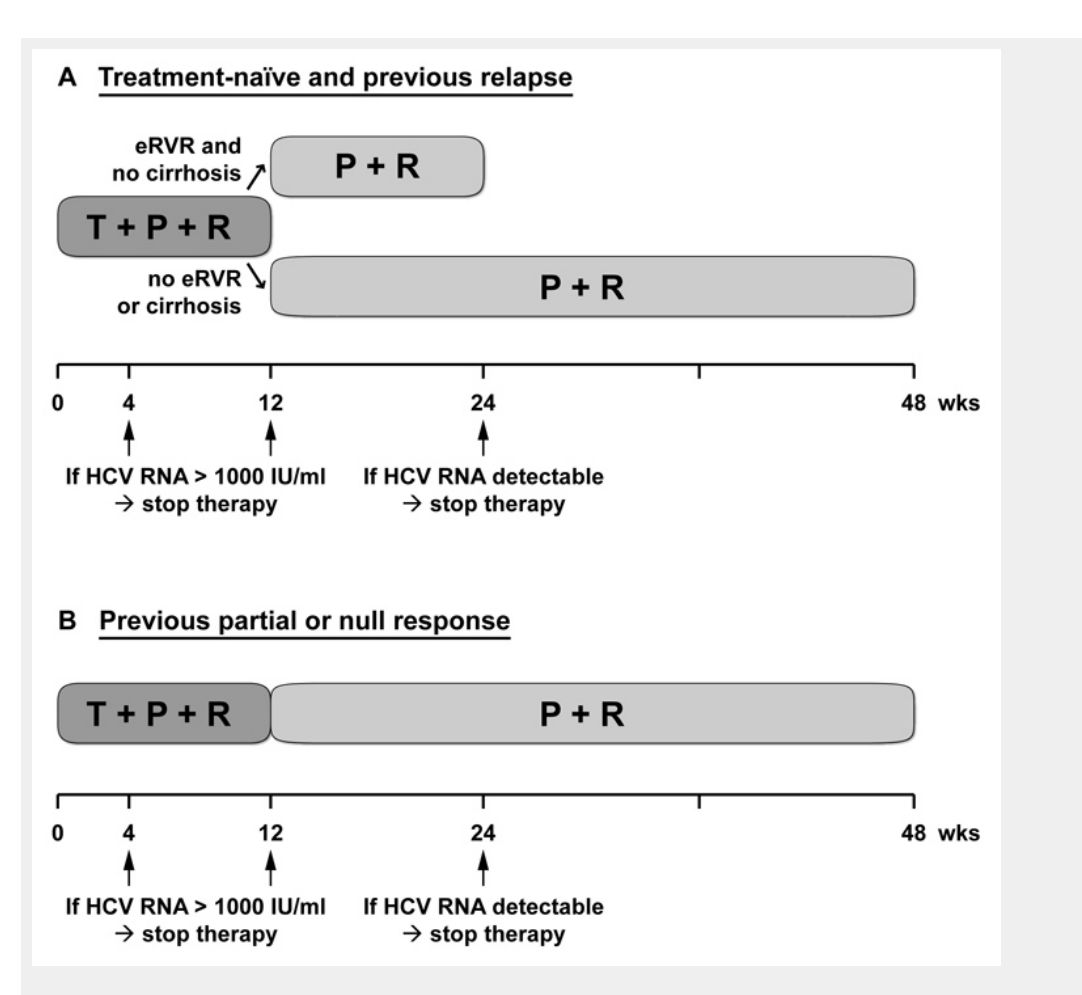
table 1 for definitions of virological response patterns); P, pegylated interferon-α; R, ribavirin; T, telaprevir; wks,